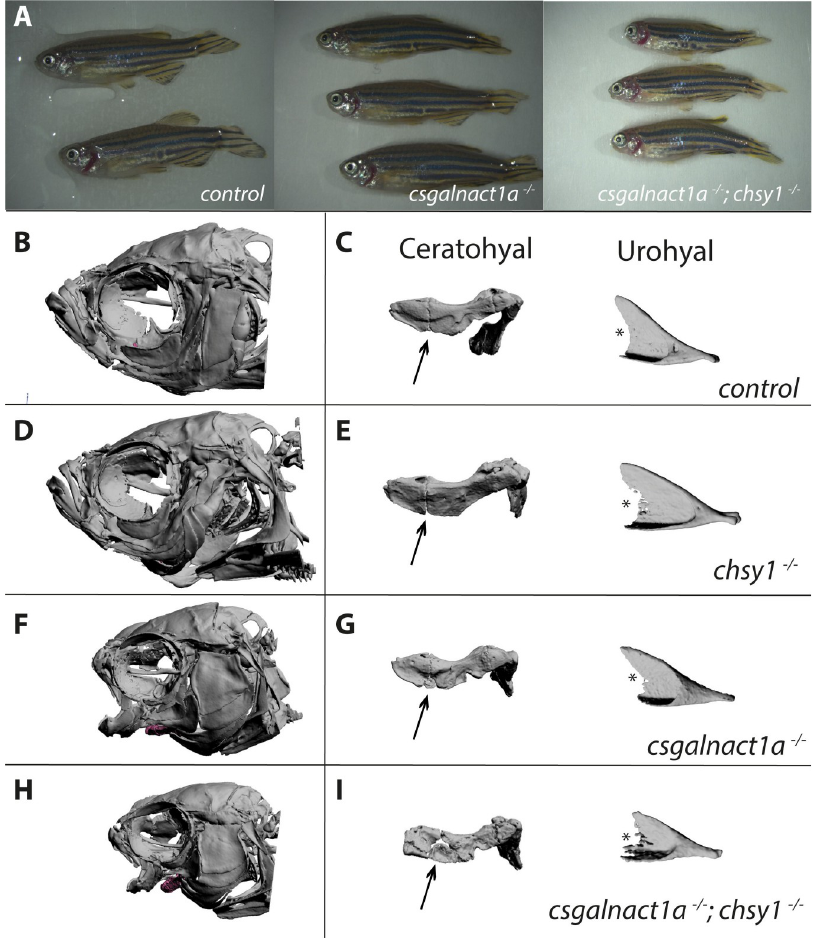
Fig 3. Severe malformation in the adult head skeleton. Alterations in the morphology of the ceratohyal and urohyal were magnified in all four genotypes (for spatial position of elements in the zebrafish head, see S1 movie). Adult csgalnact1a -/- ; chsy1 -/- zebrafish displayed gross malformations and reduced body size compared to control and csgalnact1a -/- adults (A). 3D reconstructions of all genotypes showed that no bone structures were missing (B,D,F,H and S1–S4 Figs). However, shorter and misshaped elements were common in csgalnact1a -/- (F) and csgalnact1a -/- ; chsy1 -/- fish (H), while the chsy1 -/- skeletal phenotype (D) was milder, compared to the control (B). The differences in morphological integrity of skeletal elements was evident from magnifications, for example the boundary between the anterior and the posterior part (arrow) of the ceratohyal and posterior edge ( � ) and of the urohyal (C,E,G,I and